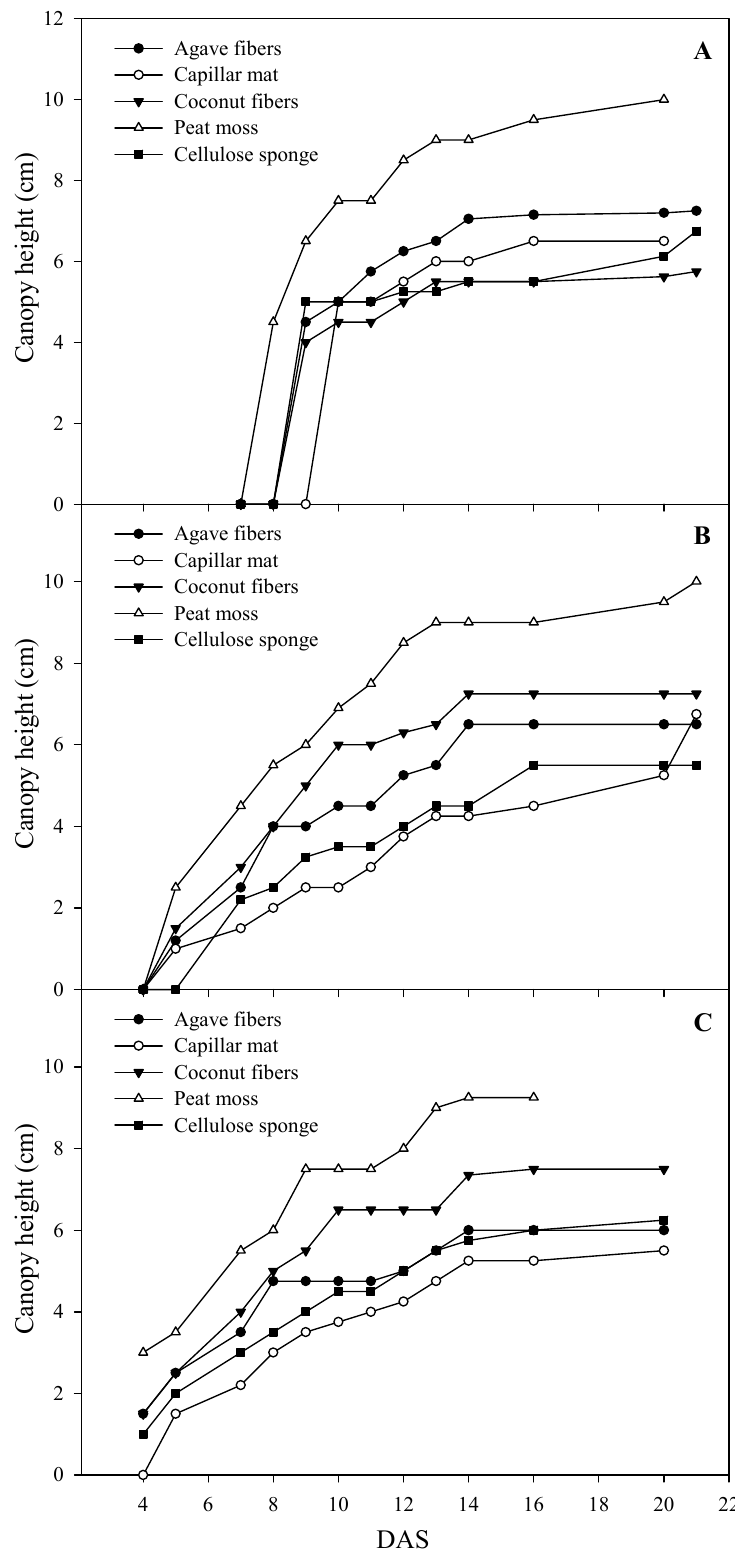
Figure 1. Canopy height of coriander ( A ), kohlrabi ( B ) and pak choi ( C ) microgreens while growing on natural fiber and synthetic substrates under controlled environment. DAS: days after sowing. All data are expressed as mean ± standard error, n = 3.